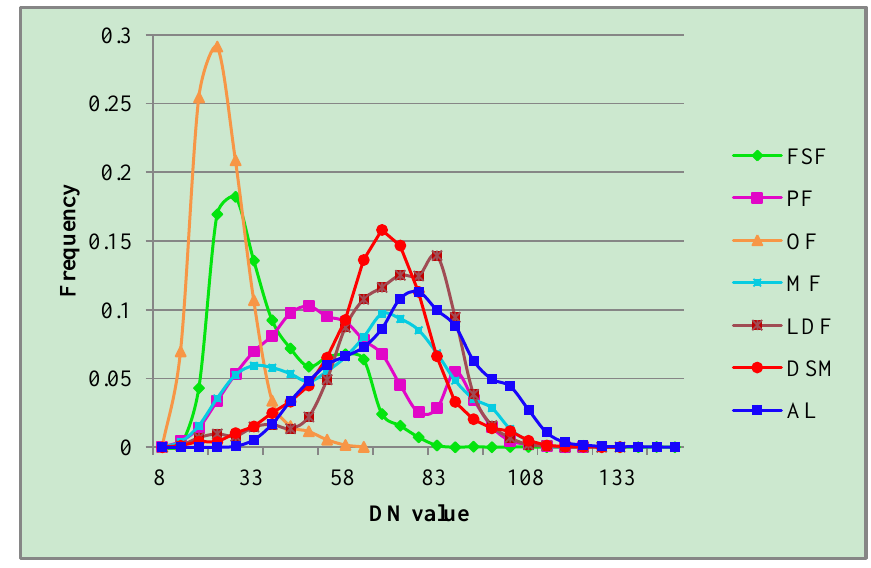
Figure 2. The frequency distribution of digital number (DN) values of the training data in the Thematic Mapper near infrared (NIR) band (band 4). FSF: fir and spruce forest; PF: Pine forest; OF: oak forest; MF: mixed forest; LDF: low density forest and tall shrub; DSM: dwarf shrub and meadow; AL: agricultural